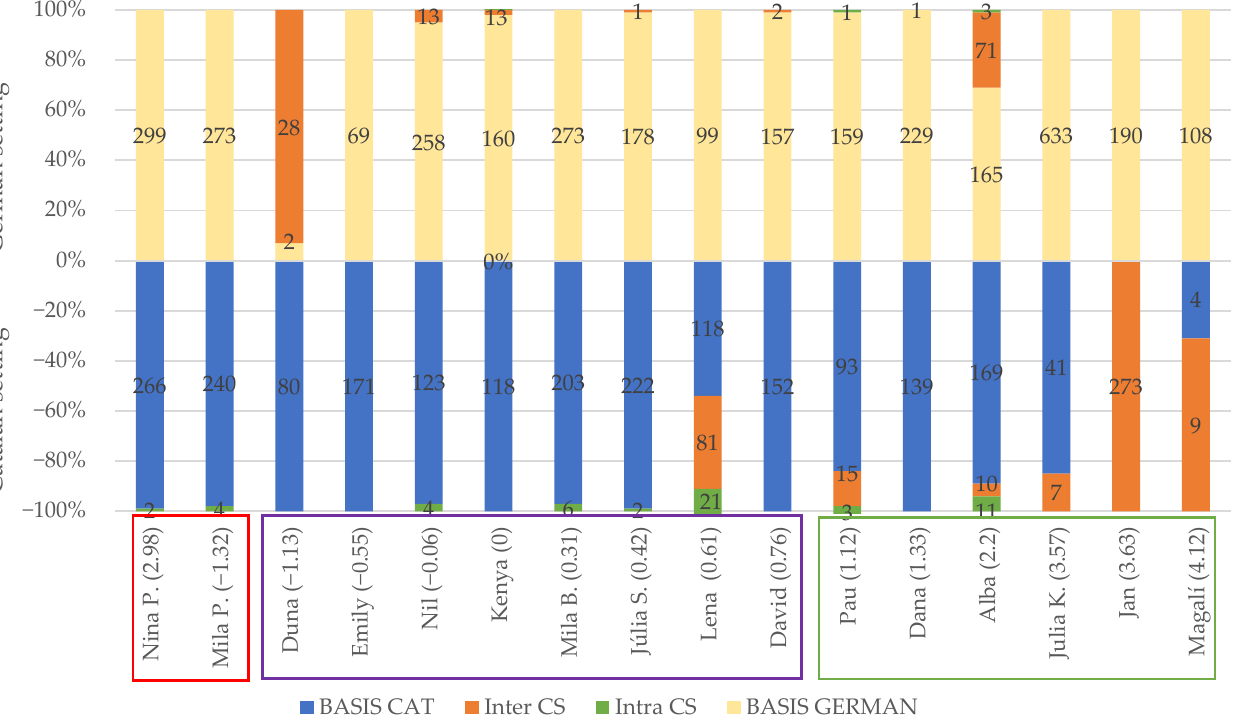
Figure 9. Inter- and intrasentential CS according to children’s language dominance (child (MLUD)). By looking at the language of the recording, we clearly observe that children with an MLUD higher than 1.0 (green square) mixed their languages in the Catalan